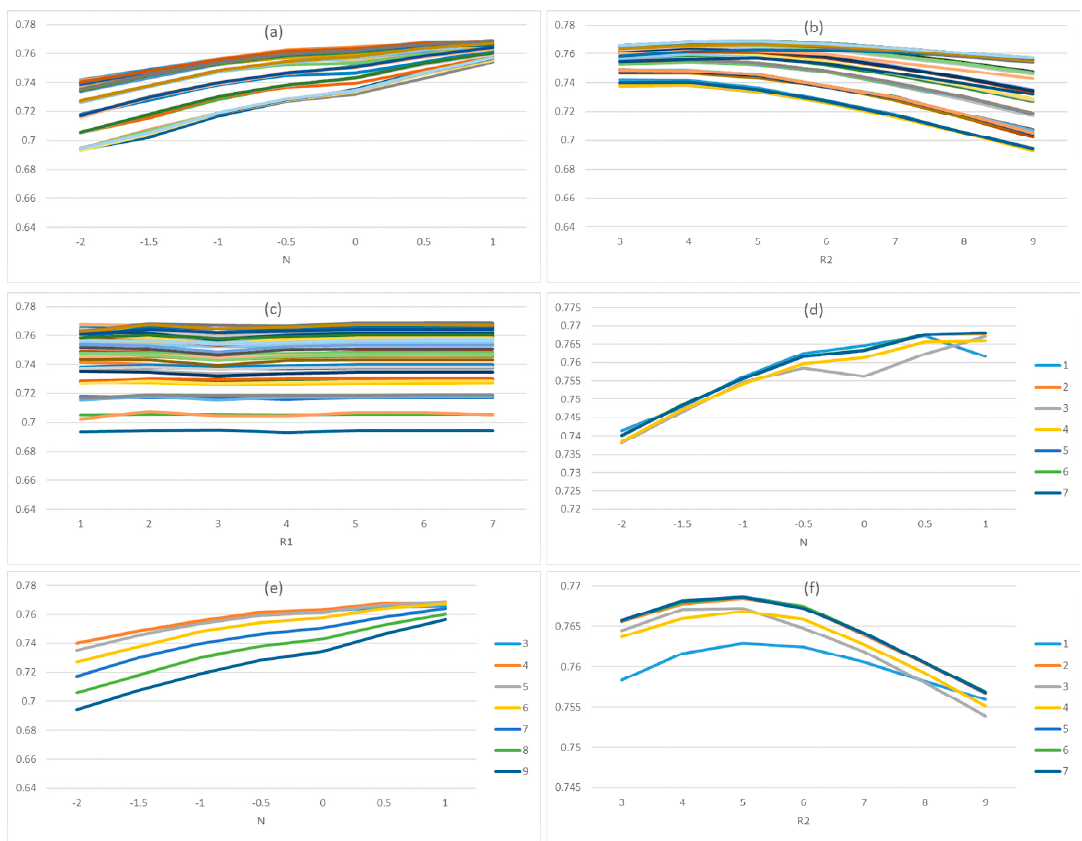
Figure 14. The Sensitivity analysis of parameters: ( a – c ) were the results of all parameter combinations; ( d ) was the results withR2 = 4; ( e ) was the results with R1 = 2; ( f ) was the results with N = 1.